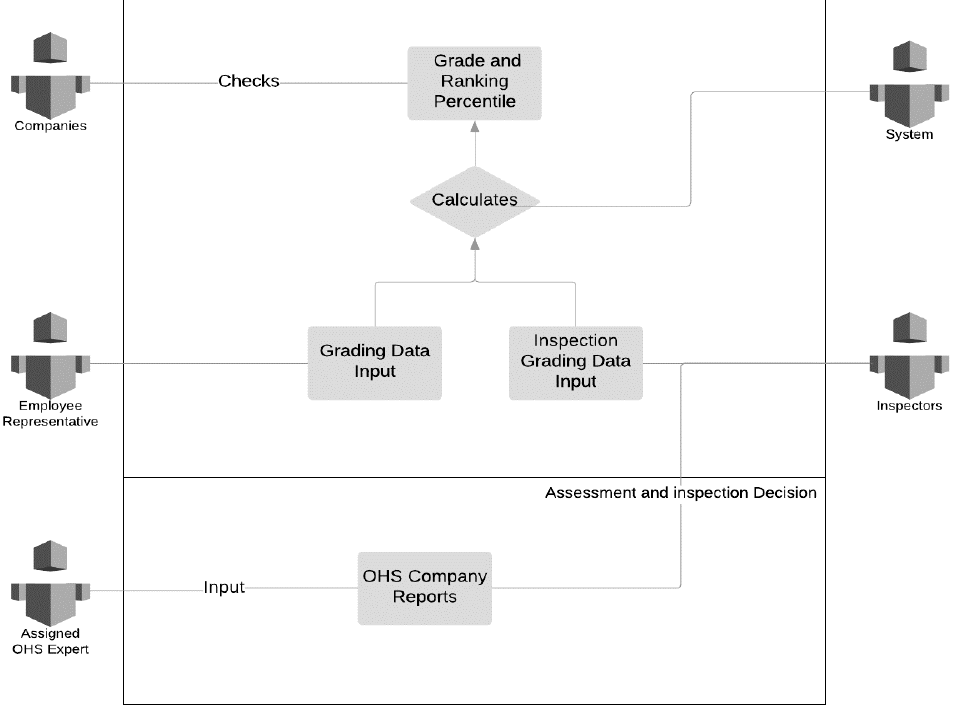
Figure 8. Use Case